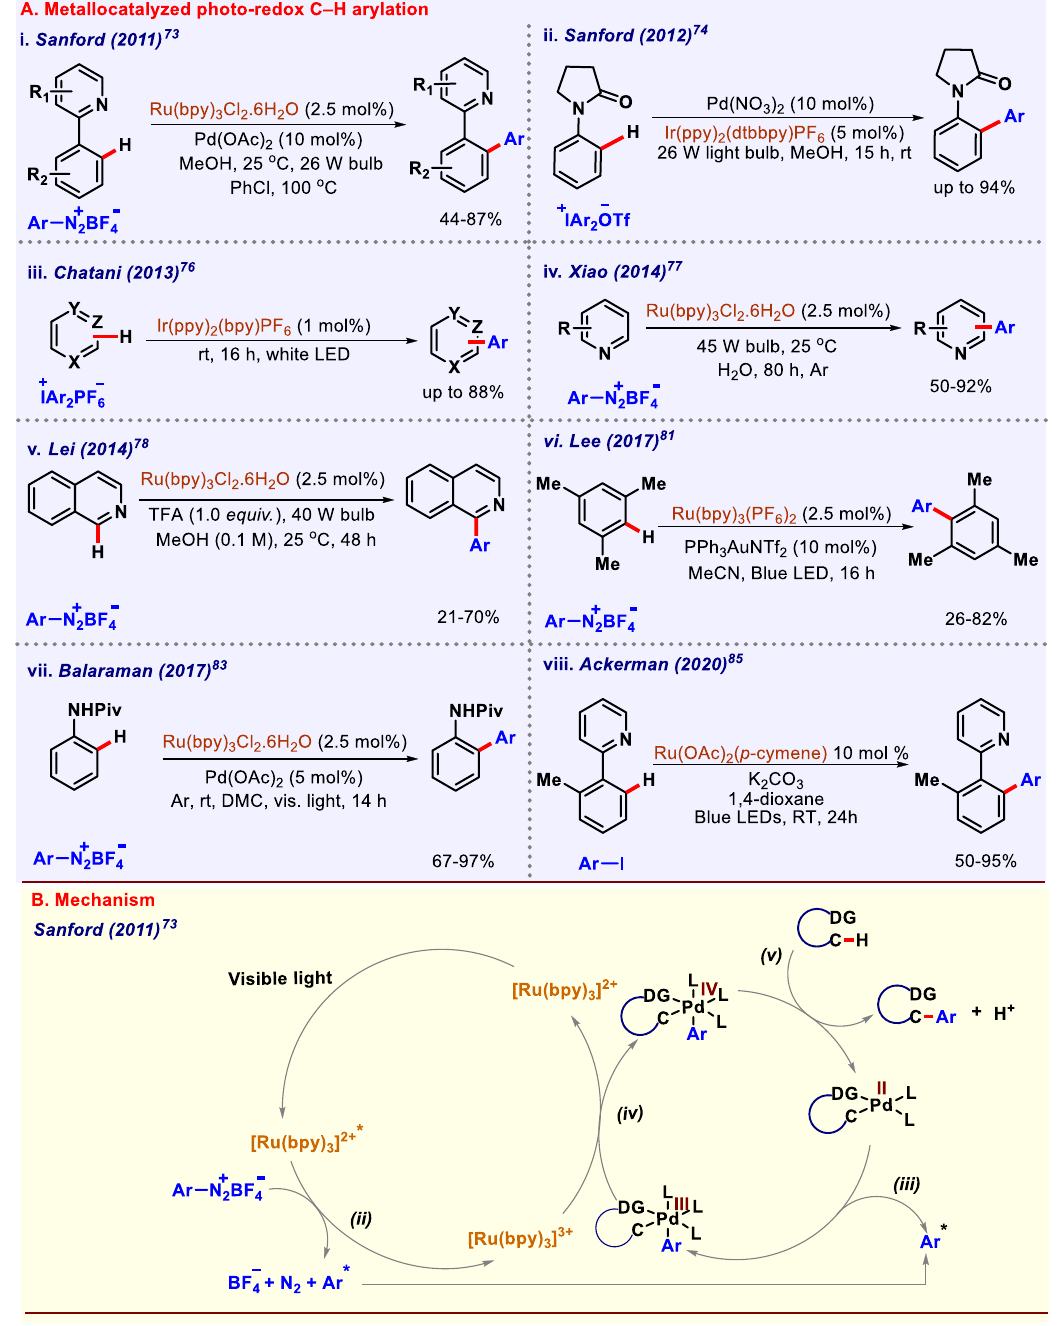
Fig. 5 Photoredox catalyzed C – H arylation. A Metallacatalyzed photoredox C – H arylation. B Mechanism of ruthenium photocatalyzed arylation of